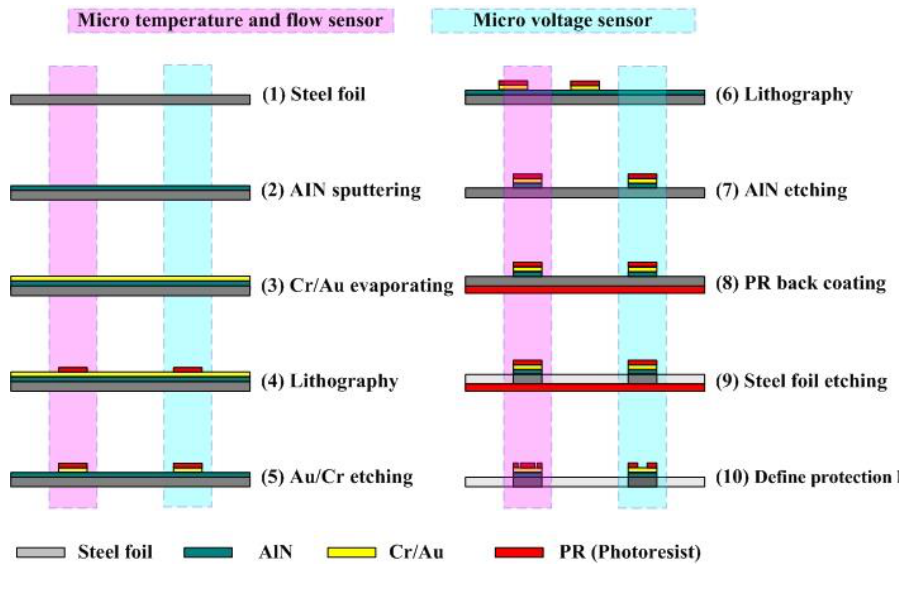
Figure 5. Etching rate of phosphoric